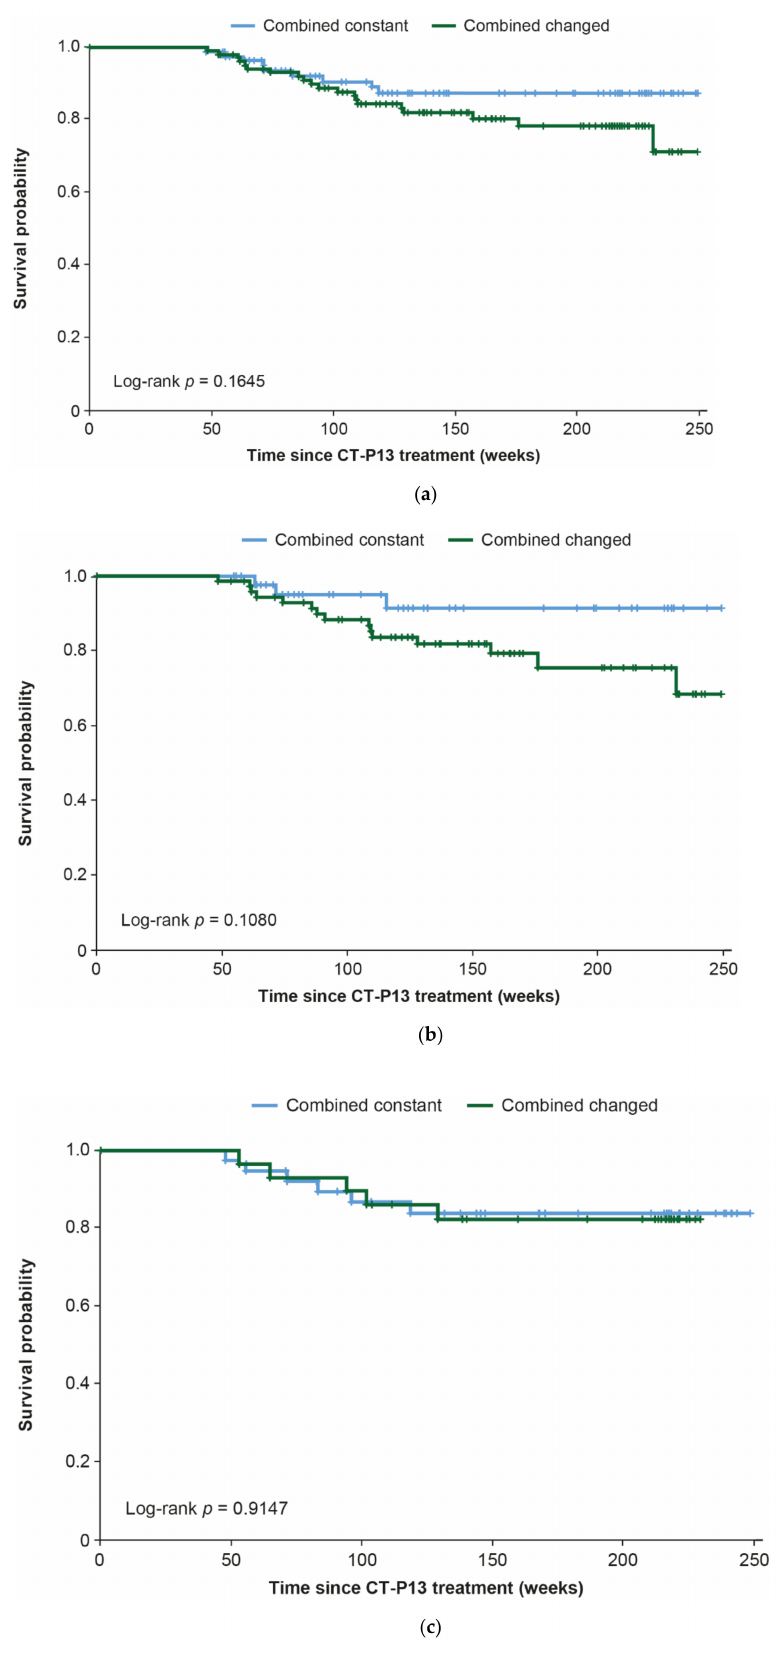
Figure 5. Drug survival for combined constant and combined changed groups: ( a ) overall, ( b ) naïve patients, and ( c ) switched